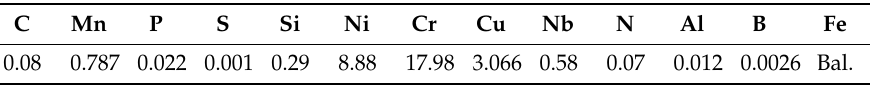
Table 1. Chemical composition of the Super304H steel (in wt.%).